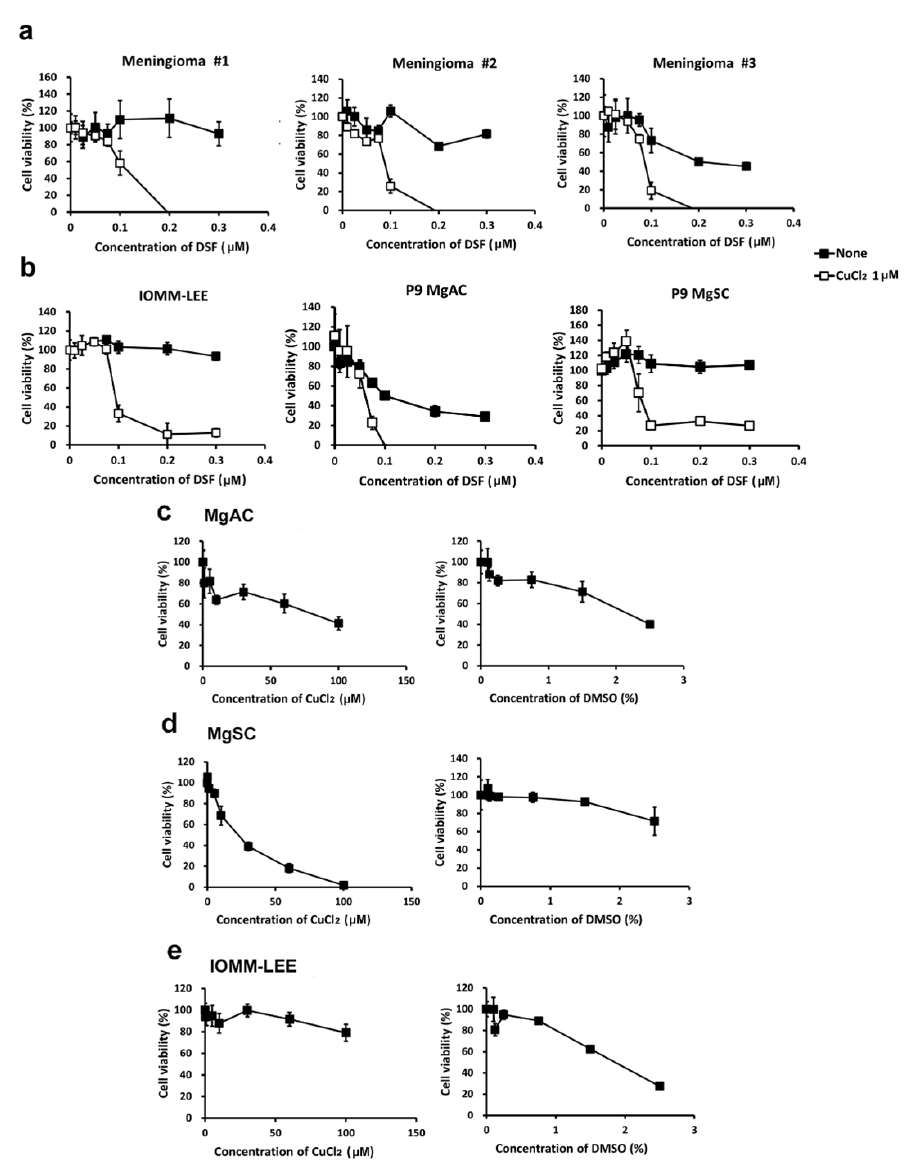
Figure 2. DSF/Cu reduced the viability of meningioma cells. Meningioma #1, #2, and #3 ( a ); IOMM- Lee; MgACs; and MgSCs ( b ) were incubated for 48 h with selected concentrations of disulfiram (DSF, 0 µ M, 0.01 µ M, 0.025 µ M, 0.05 µ M, 0.075 µ M, 0.1 µ M, 0.2 µ M, and 0.3 µ M), with or without 1 µ M CuCl 2 . ( c – e ) MgACs, MgSCs, and IOMM-Lee were incubated for 48 h with selected concentrations of Cu 2+ (CuCl 2 ) (0 µ M, 0.1 µ M, 1 µ M, 5 µ M, 10 µ M, 30 µ M, 60 µ M, and 100 µ M) or DMSO (control) (0%, 0.1%, 0.125%, 0.25%, 0.75%, 1.5%, and 2.5%). Cell viability was assessed with MTS assays. Results are presented as the mean ± SD of triplicate samples from representative data from three independent